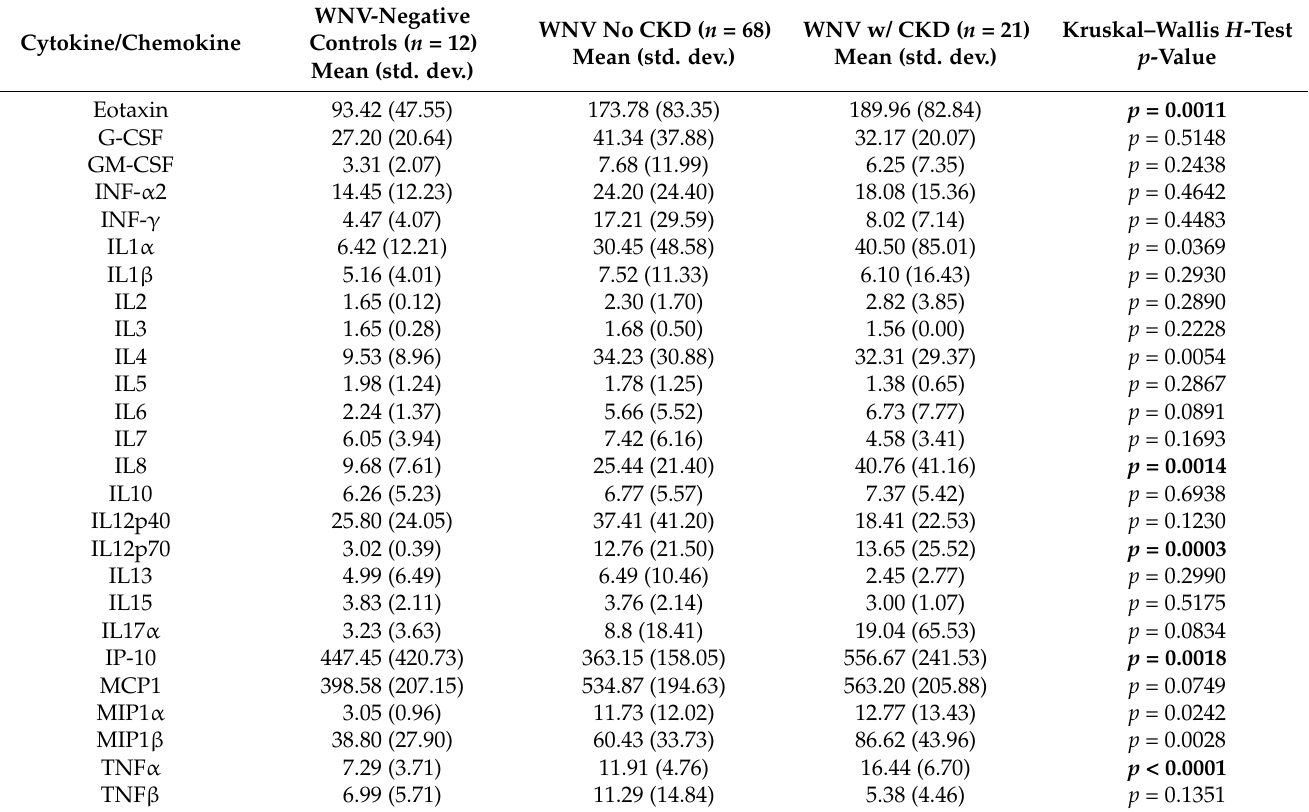
Table 3. Mean Concentration (pg/mL) and Standard Deviation (std. dev.) of 26 Cytokines in Serum with Comparison between the Three Groups.